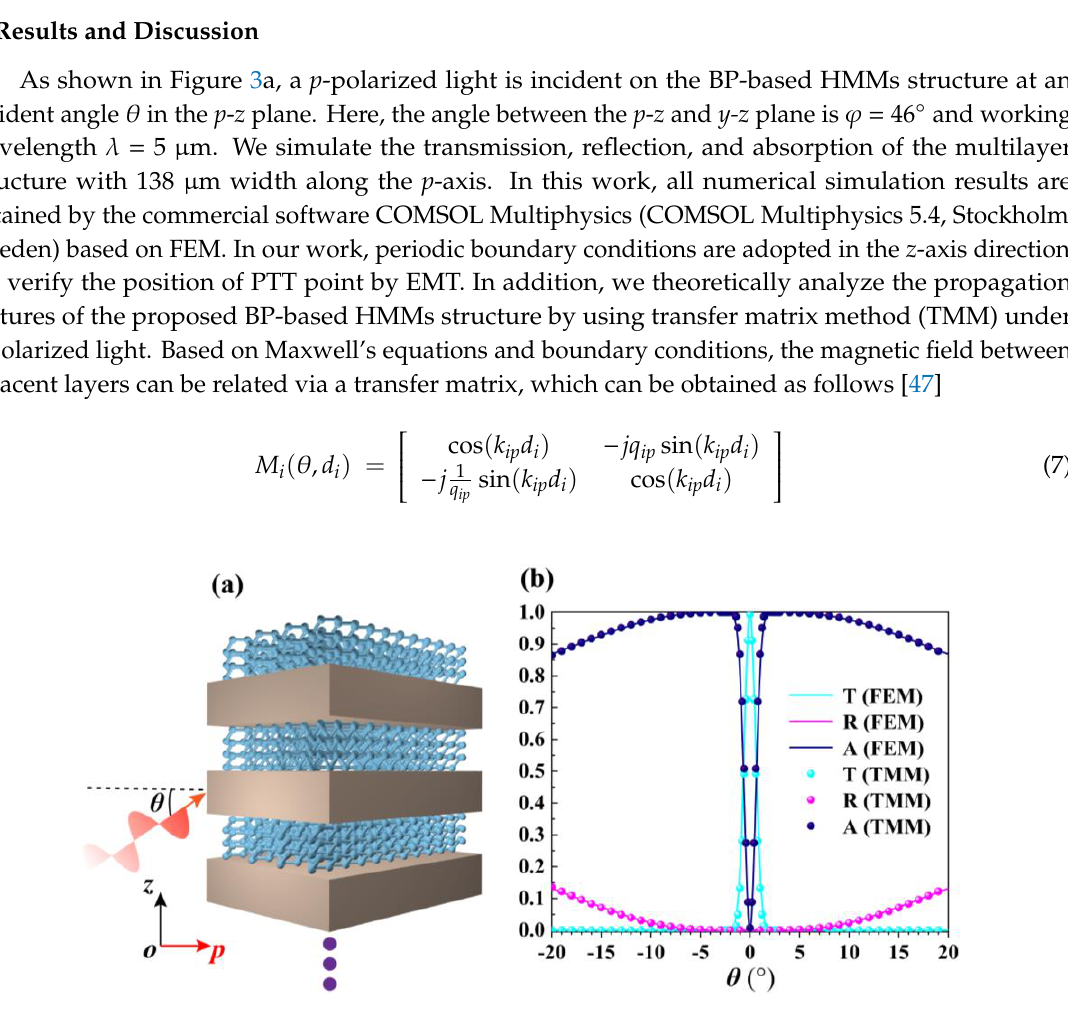
Figure 3. (a) The p - z view of the proposed BP-based HMMs structure and a p -polarized light is incident on the structure at an incident angle θ . (b) Transmission ( T ), reflection ( R ), and absorption BP-based HMMs structure under λ = 5 µ m, ρ = 5 × 10 13 cm − 2 , and t d = 300 nm. The curve (dots) are ( A ) of BP-based HMMs structure under λ = 5 μm, ρ = 5 × 10 13 cm −2 , and t d = 300 nm. The curve (dots) numerical (theoretical) results obtained by the FEM are numerical (theoretical) results obtained by the FEM (TMM).